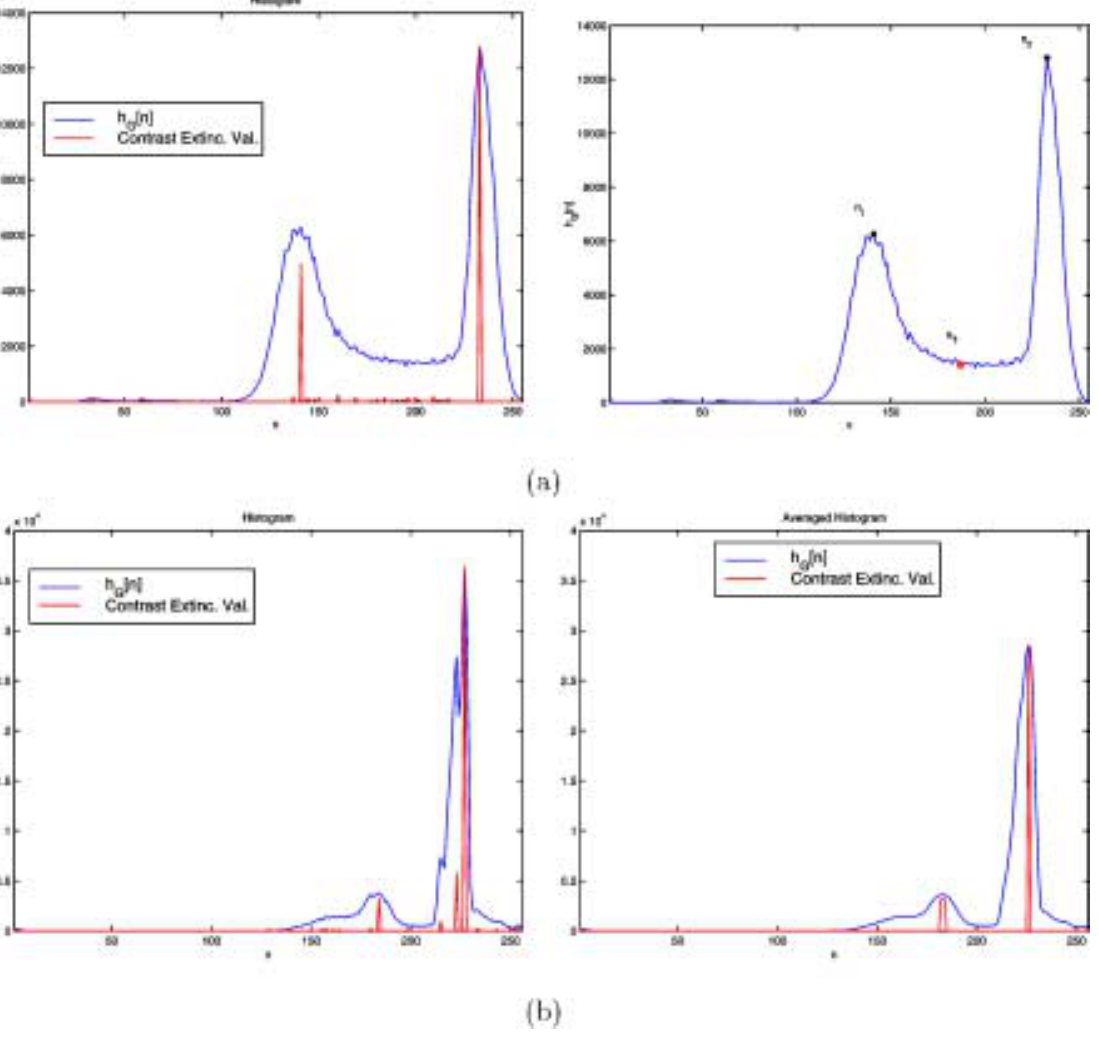
Fig. 4. Histograms and optimal thresholding: (a) On the left, histogram and contrast extinction values; on the right, maxima n 1 and n 2 (the two peaks of largest dynamic or the first two most relevant peaks), and optimal threshold value u T . (b) On the left, histogram and contrast extinction values; on the right, smoothed histogram and new contrast extinction values. This figure can be viewed on http://www.esacp.org/acp/2003/